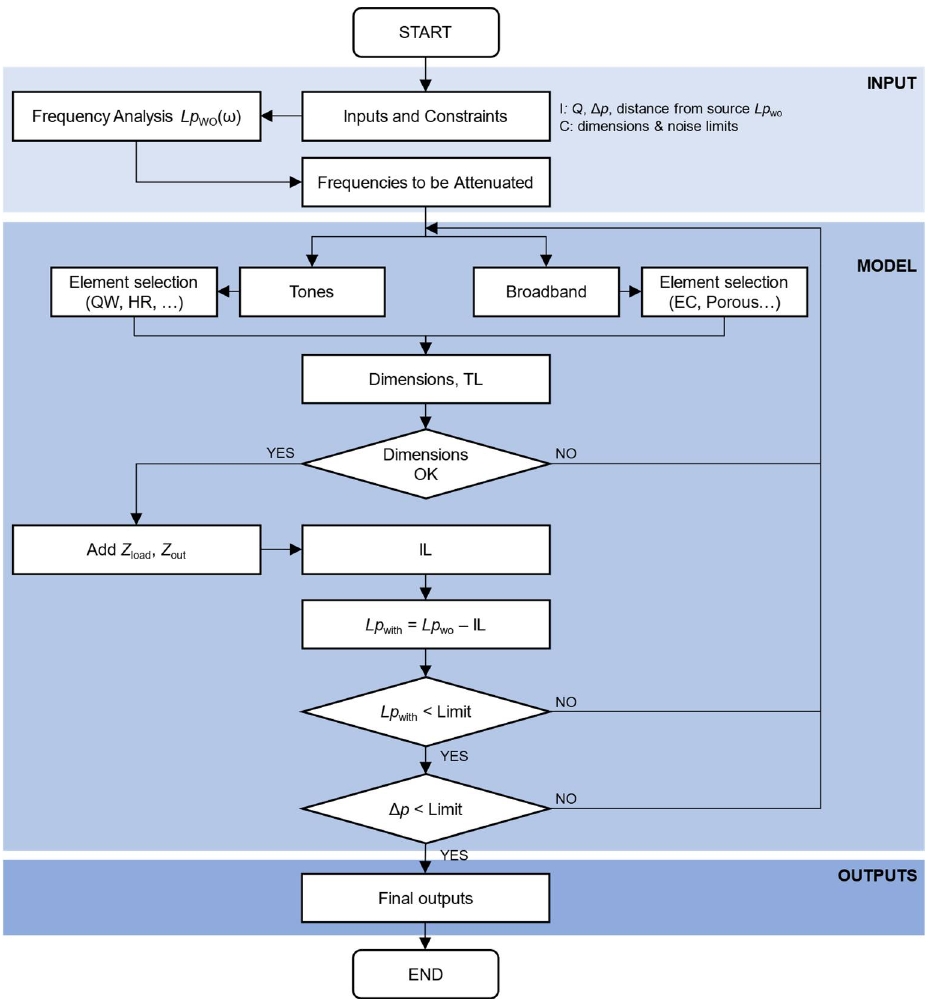
Figure 8. Flowchart showing the steps to be followed during the design process. QW, HR, and EC indicate quarter-wavelength resonator, Helmholtz resonator, and expansion chamber, respectively.